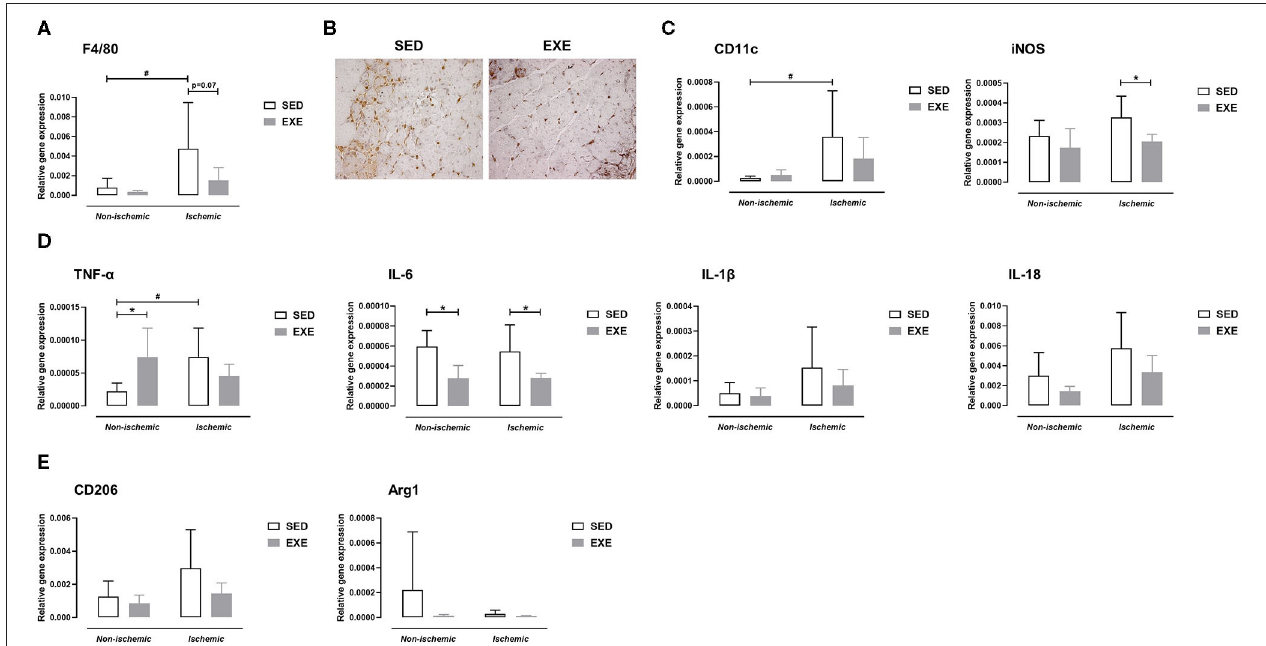
FIGURE 5 | Effect of preventive exercise on hindlimb muscle inflammation of ApoE − / − mice 1 week after PAD. (A) Gene expression analysis by real-time RT-PCR of the F4/80 macrophage marker in non-ischemic and ischemic gastrocnemius muscles of SED and EXE mice ( n = 6 animals per group). (B) Representative images of ischemic gastrocnemius cross-sections stained with anti-Mac-2 (in brown) at × 20 high-power field. (C-E) Gene expression analysis by real-time RT-PCR of pro-inflammatory M1 macrophage markers (C) , M1-related pro-inflammatory cytokines (D) , and of anti-inflammatory M2 macrophage markers (E) in non-ischemic and ischemic gastrocnemius muscles of SED and EXE mice ( n = 4-6 animals per group). Two-way ANOVA with Sidak’s multiple comparisons test in (A,C-E) : # p < 0.05 vs. respective non-ischemic; * p < 0.05 vs. SED. Bar graphs represent mean ± SD.